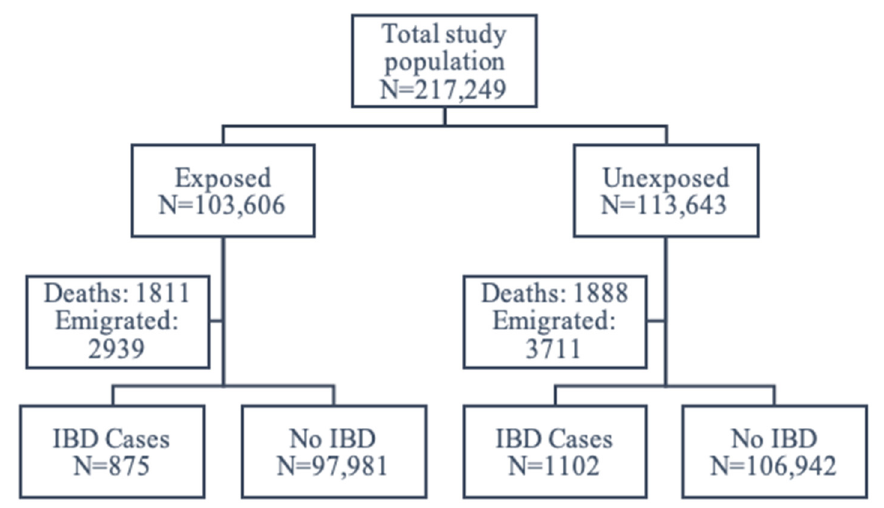
Figure 2. Flowchart of the study population.